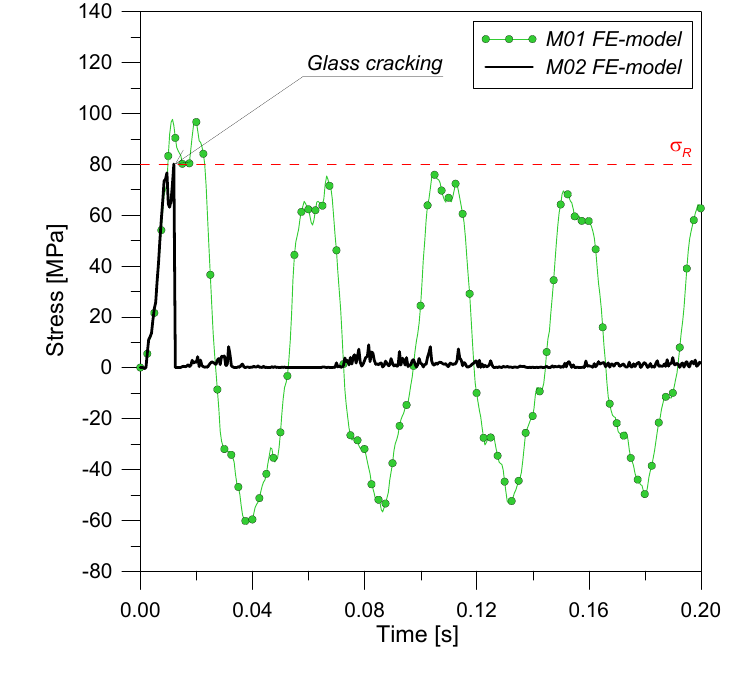
Figure 12. Comparison of maximum tensile stress at the center of panel (inner glass